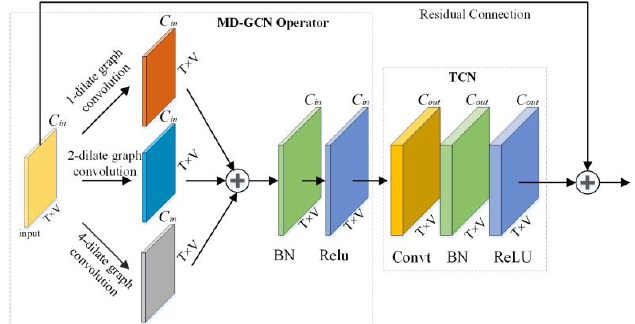
Figure 5. The architecture of the MD-GCN classification network.